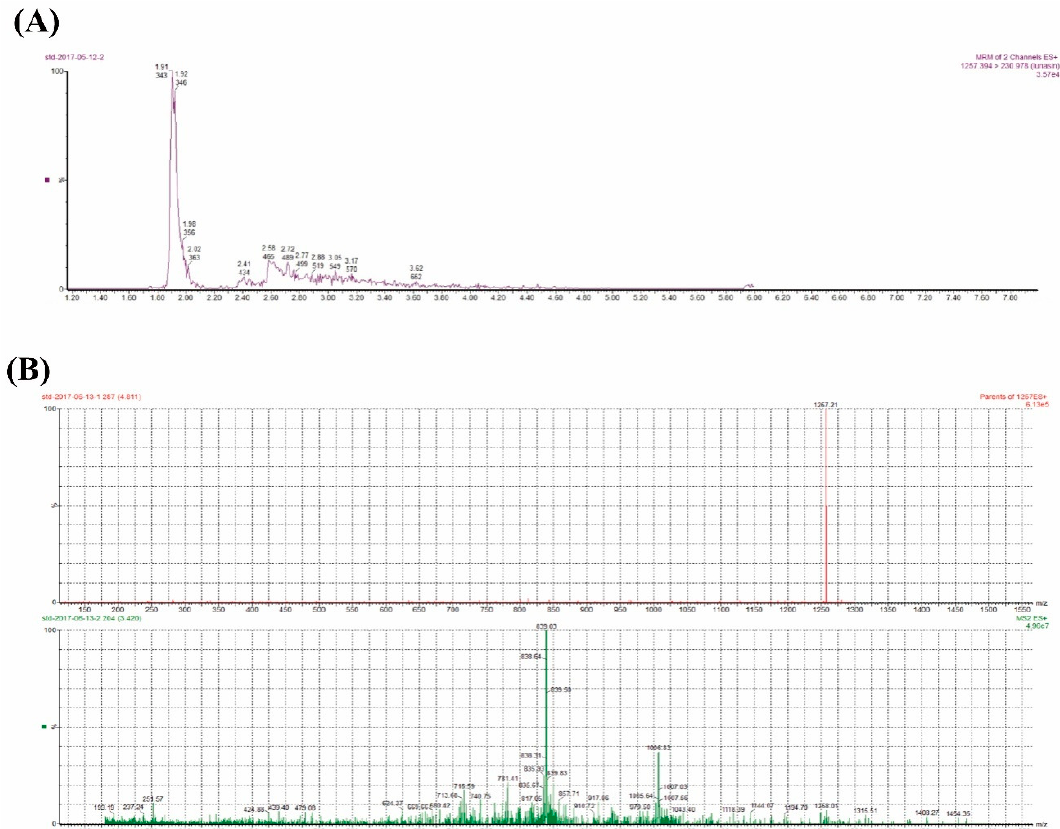
Figure 2. UPLC-MS/MS analysis. ( A ) Multiple reaction monitoring (MRM) chromatogram of the lunasin standard. ( B ) Mass spectrum acquired from the peak at 1.91 min in the MRM chromatogram of the lunasin standard.